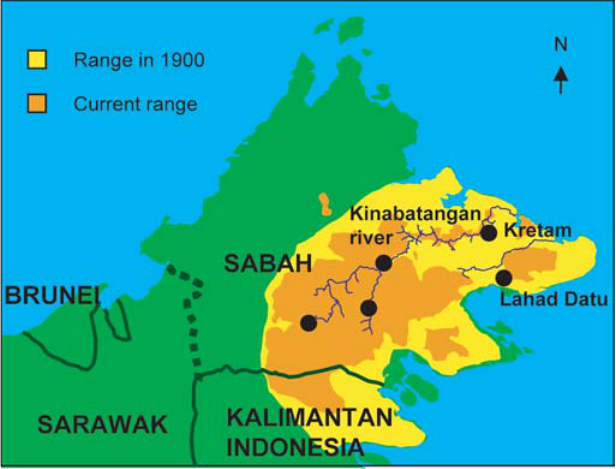
Figure 1. Asian Elephant Range and Sampling Locations in Borneo Solid lines demarcate country borders and the dotted line the boundary between the Malaysian states of Sabah and Sarawak. Black dots indicate areas of sample collection. DOI: